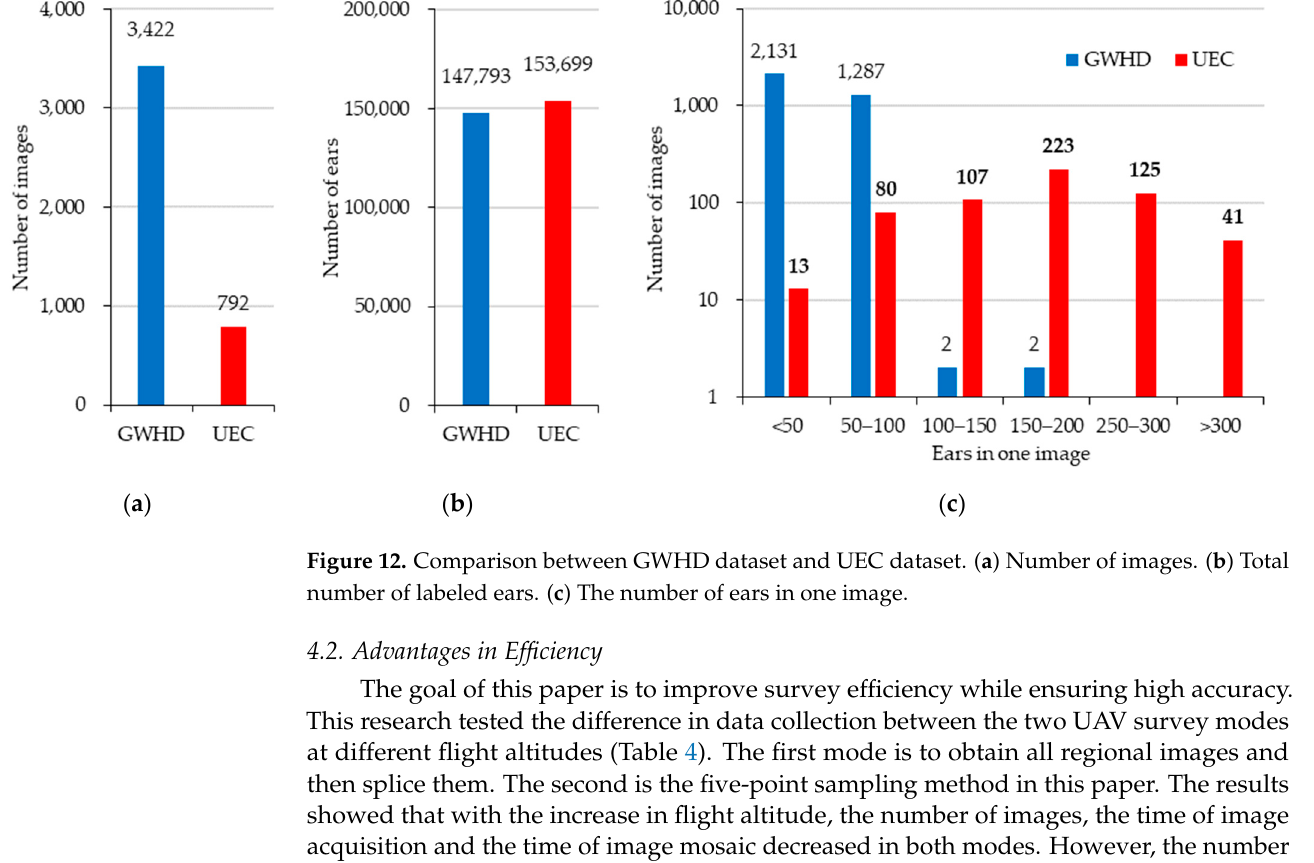
Figure 11. Representative images of GWHD dataset and UEC dataset.